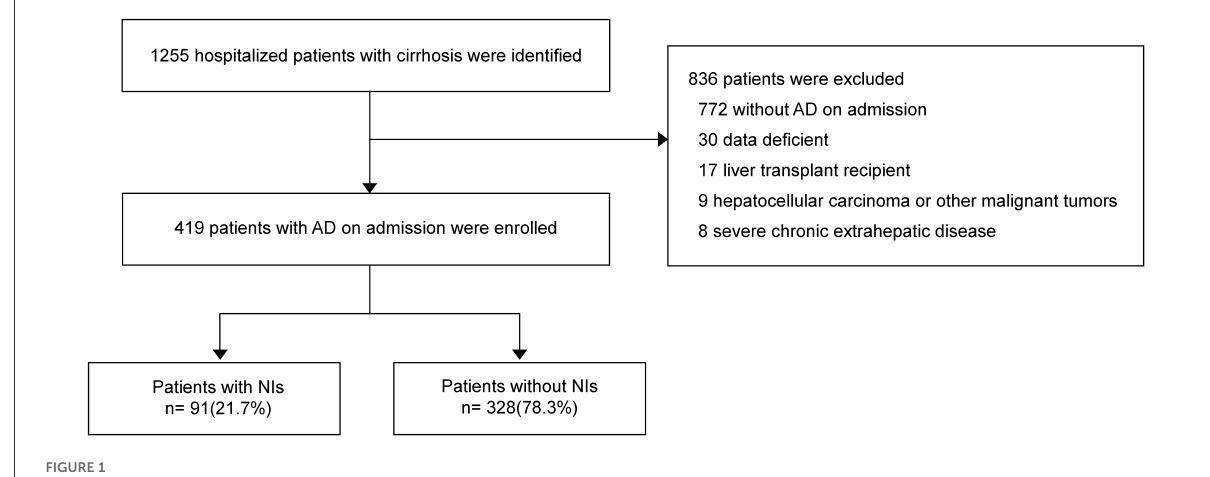
FIGURE1 Flow chart for patient